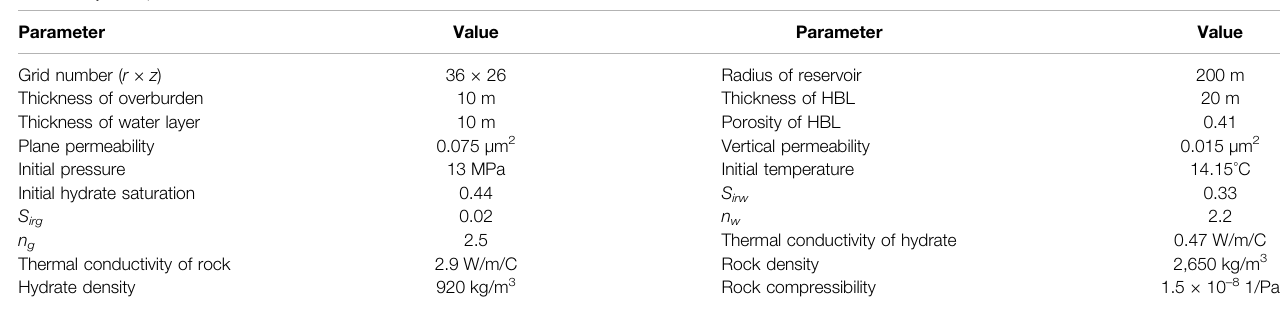
TABLE 2 | Main parameters of the model.